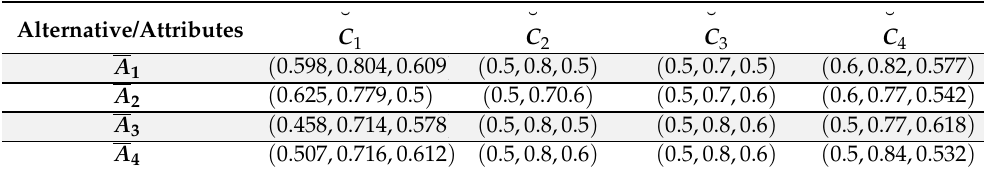
Table 13. Aggregated matrix by using data in Tables 1–3.